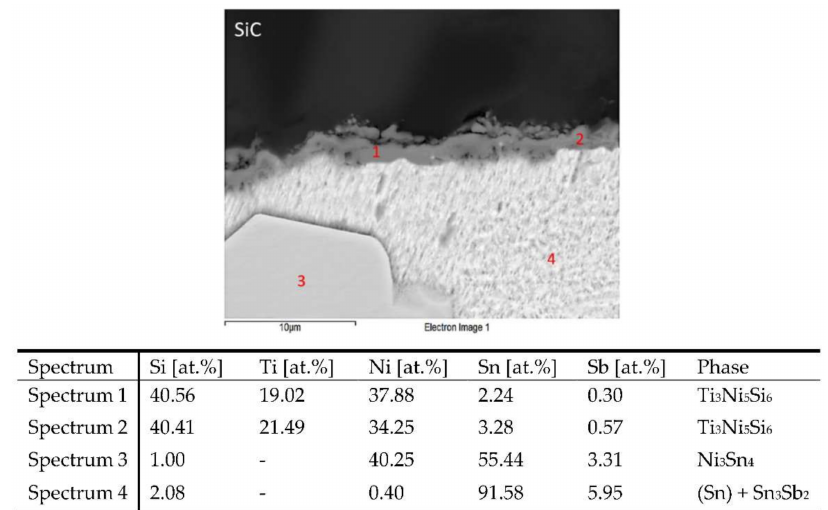
Figure 13. Point EDX analysis of SiC/Sn5Sb3Ti joint boundary.